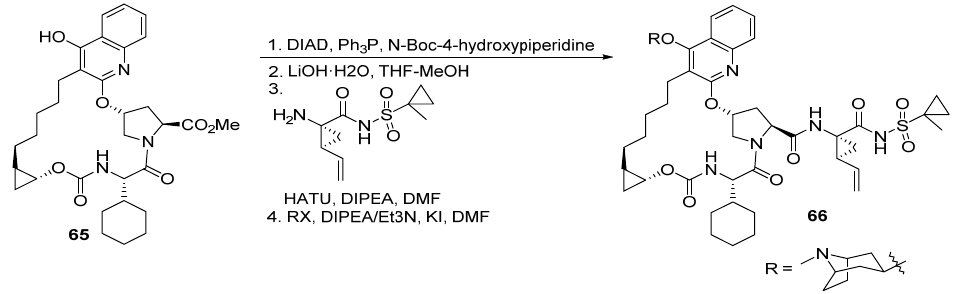
Scheme 15. Synthesis of the inhibitor to target HCV NS3/4a protease.